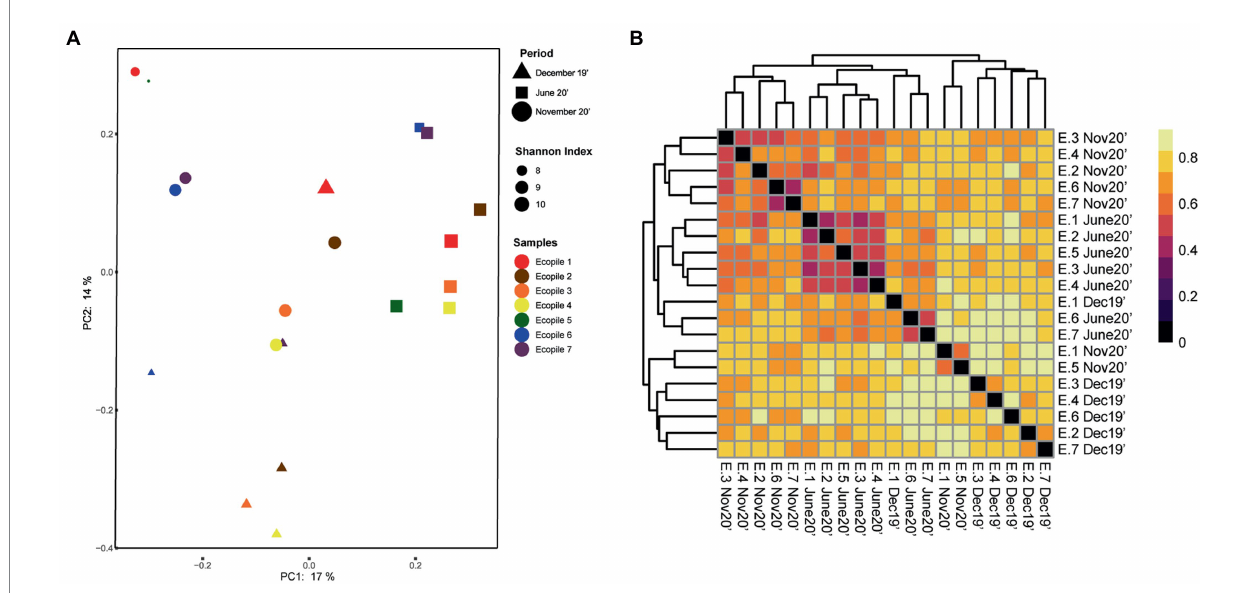
FIGURE 3 Clustering analysis of the bacterial communities within Ecopiles at the different timepoints. (A) Principal coordinate analysis (PCoA) of Ecopiles using Bray-Curtis distances. Colors according to Ecopile, shapes according to timepoint and size according to Shannon index. Averages for each ecopile and sampling time are represented. (B) Heatmap of the hierarchical clustering of Ecopiles using Bray-Curtis distances and dendrogram. Color scale indicates Bray-Curtis